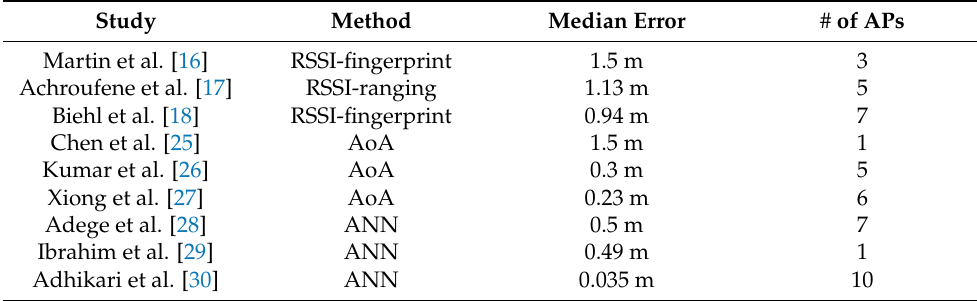
Table 1. Ranging accuracy in previous work.